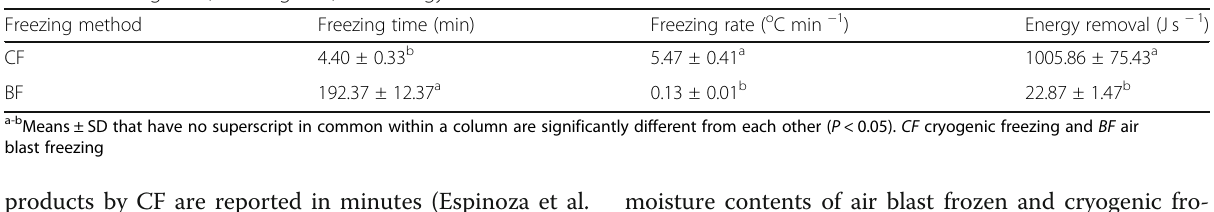
Table 2 Freezing time, freezing rate, and energy removal of crawfish minced meat